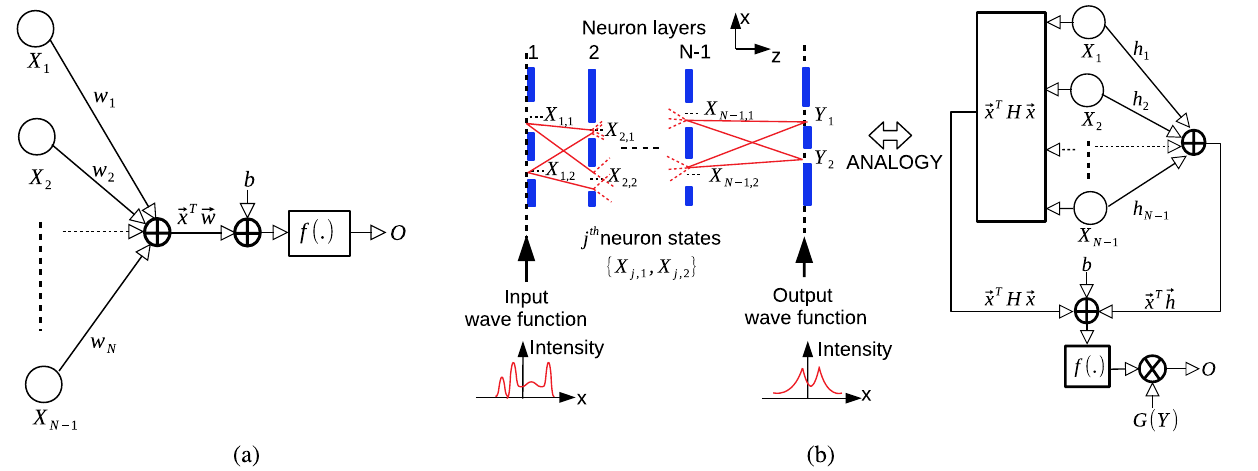
Figure 6. ( a ) Classical artificial neuron implementation with the weight and input vectors of respectively, activation function f (.), bias b and the output O . ( b ) QPC based design of QNNs with quadratic weighting relationship of superposition and interference combining the